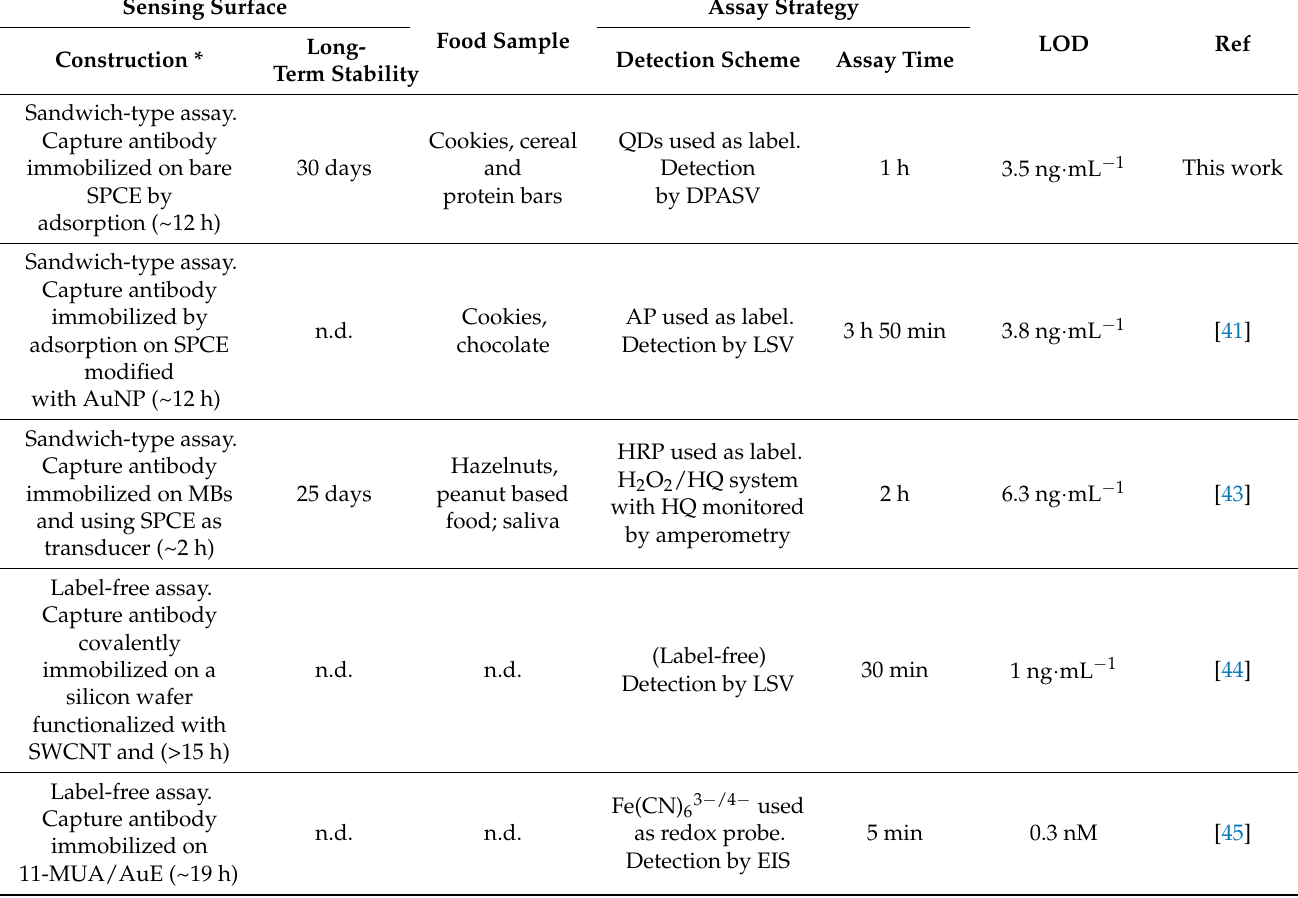
Table 1. Summary of electrochemical immunoassays for Ara h 1